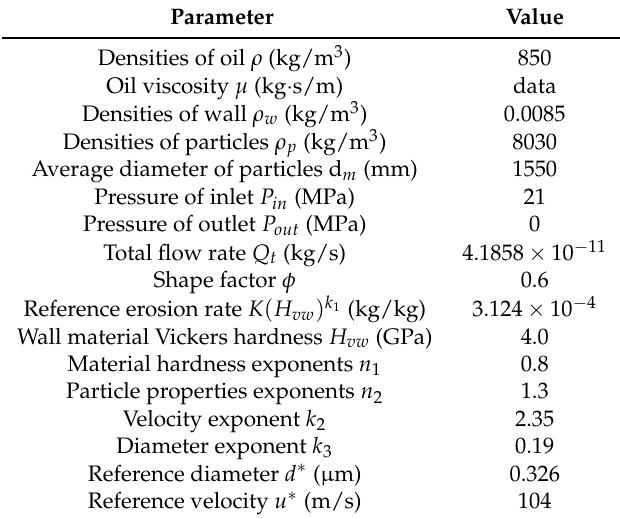
Table 4. Calculation conditions of erosion wear simulation.